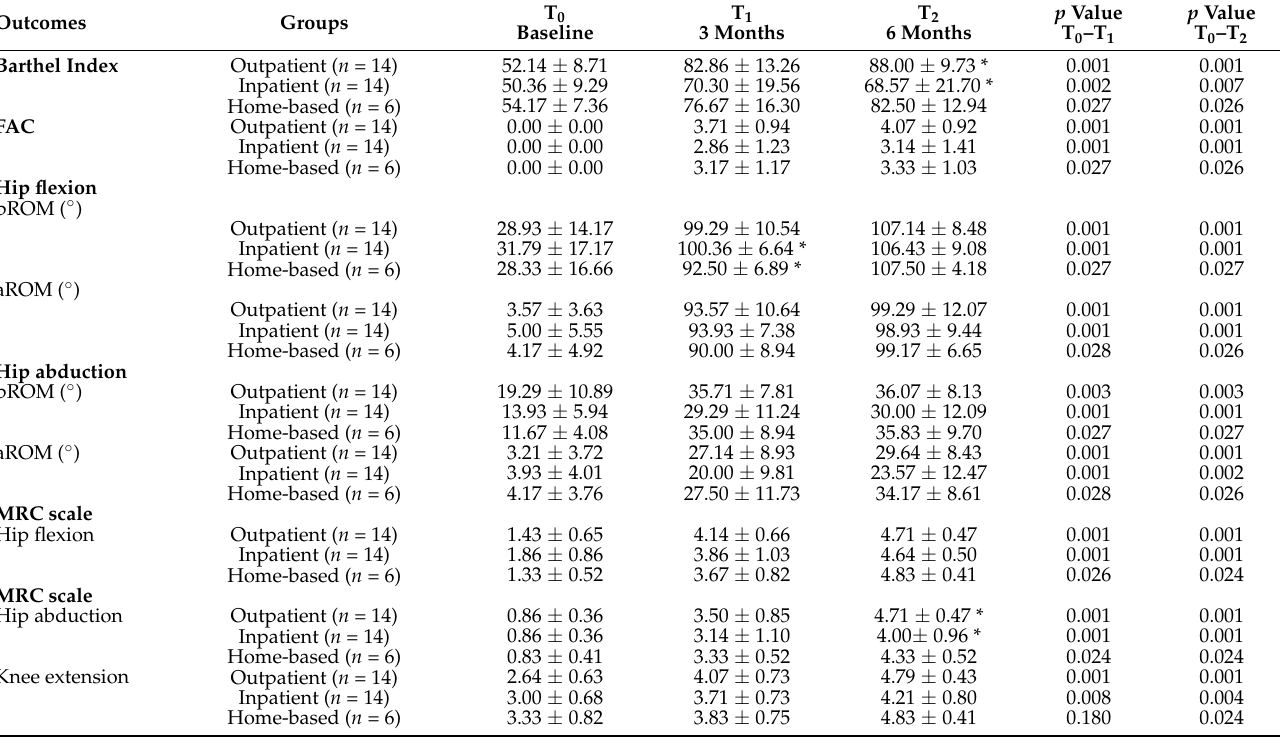
Table 2. Outcome measures assessed in the three groups at the different